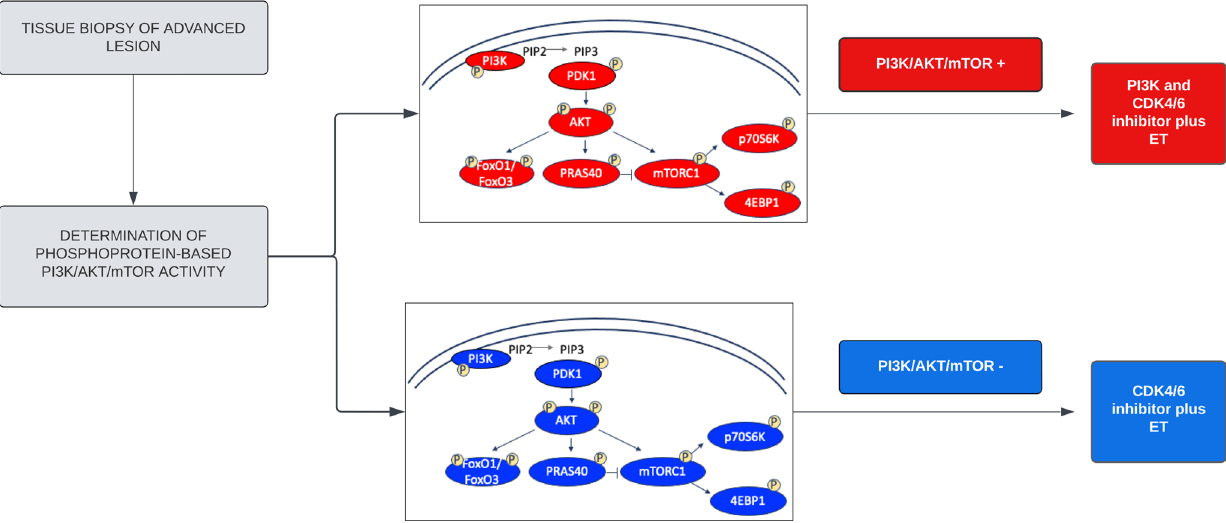
Fig. 7 Decision-making work fl ow for selecting treatment for newly diagnosed ER + /HER2- metastatic breast cancer patients. Phosphoproteomic-based quanti fi cation of PI3K/AKT/mTOR activity in tumor samples using the LCM/RPPA work fl ow allows to identify patients with high pathway activation that may bene fi t from the addition of a PI3K inhibitor to sensitize resistant tumors to ET in combination with CDK4/6